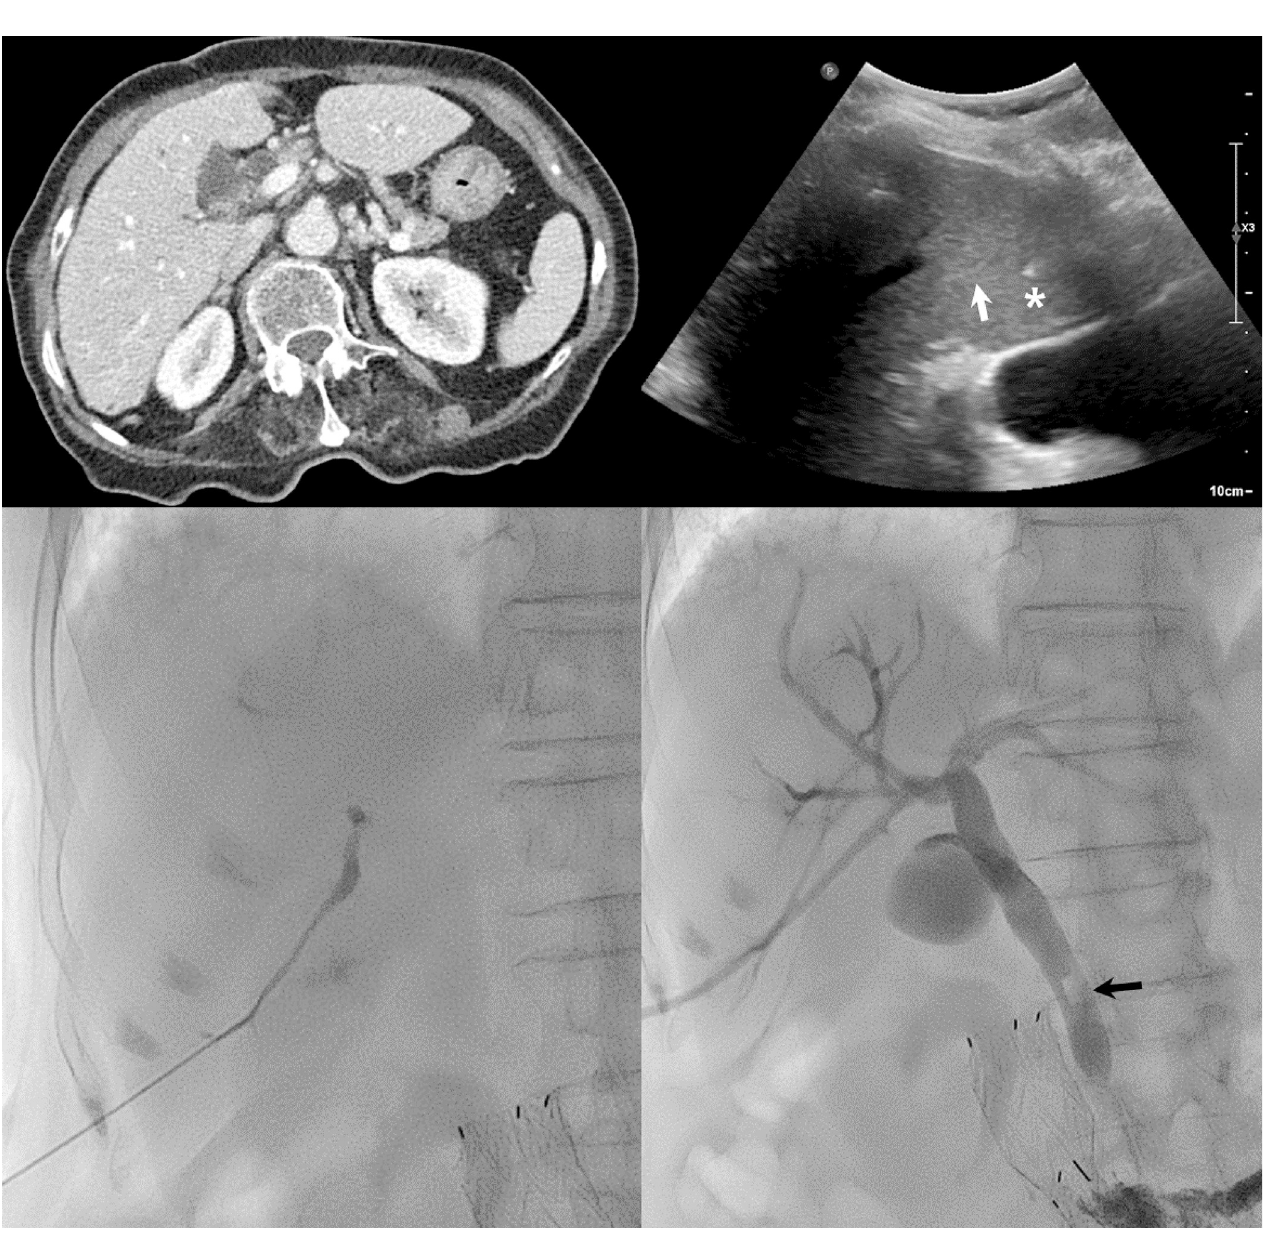
Fig 3. An 86-year-old woman with jaundice due to common bile duct stone. A. Venous contrast-enhanced computed tomography scan demonstrates minimal dilatation of intrahepatic bile ducts. B. Intercostal right lobe ultrasonography scan shows only portal vein (white arrow). A 21-gauge Chiba needle was inserted into the portal vein using a parallel technique (white asterisk). C. Insertion of the Chiba needle was followed by removal of the core needle, and a mixture of iodine contrast and normal saline solution was carefully injected while withdrawing the needle until bile ducts were visible on fluoroscopy. D. An 8.5 Fr drainage catheter was inserted at hilar level. Final cholangiography reveals a small stone in the distal common bile duct (black